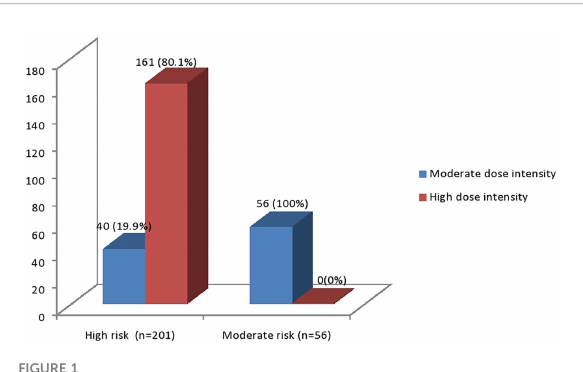
FIGURE 1 Cardiovascular risk strati fi cation in relation to statin dose-intensity among T2DM patients,